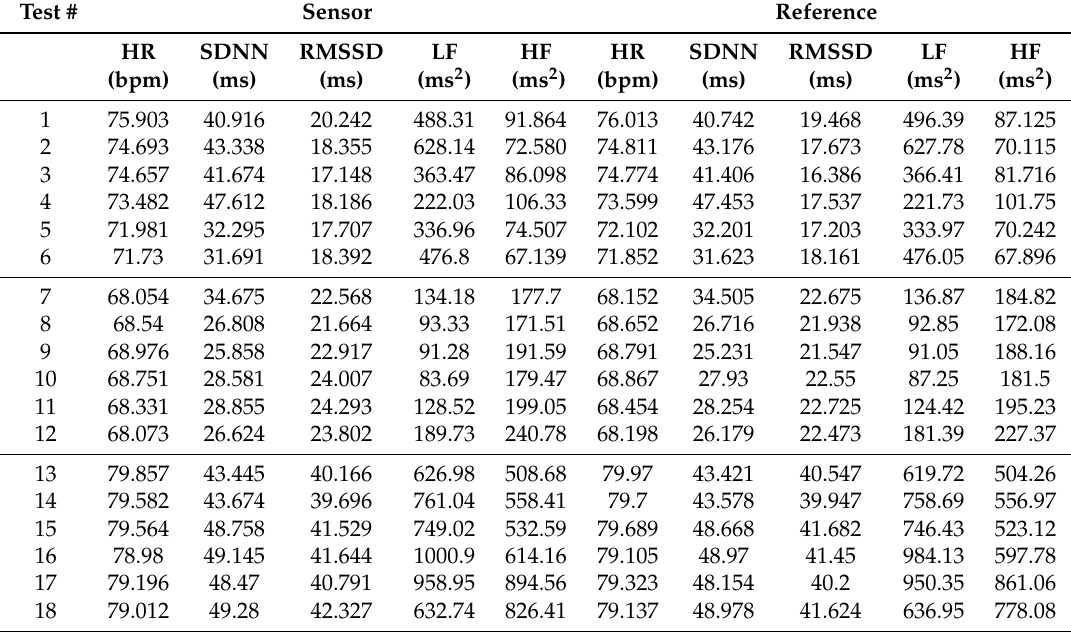
Table 1. Comparison between developed sensor and reference for principal heart rate variability (HRV) features.